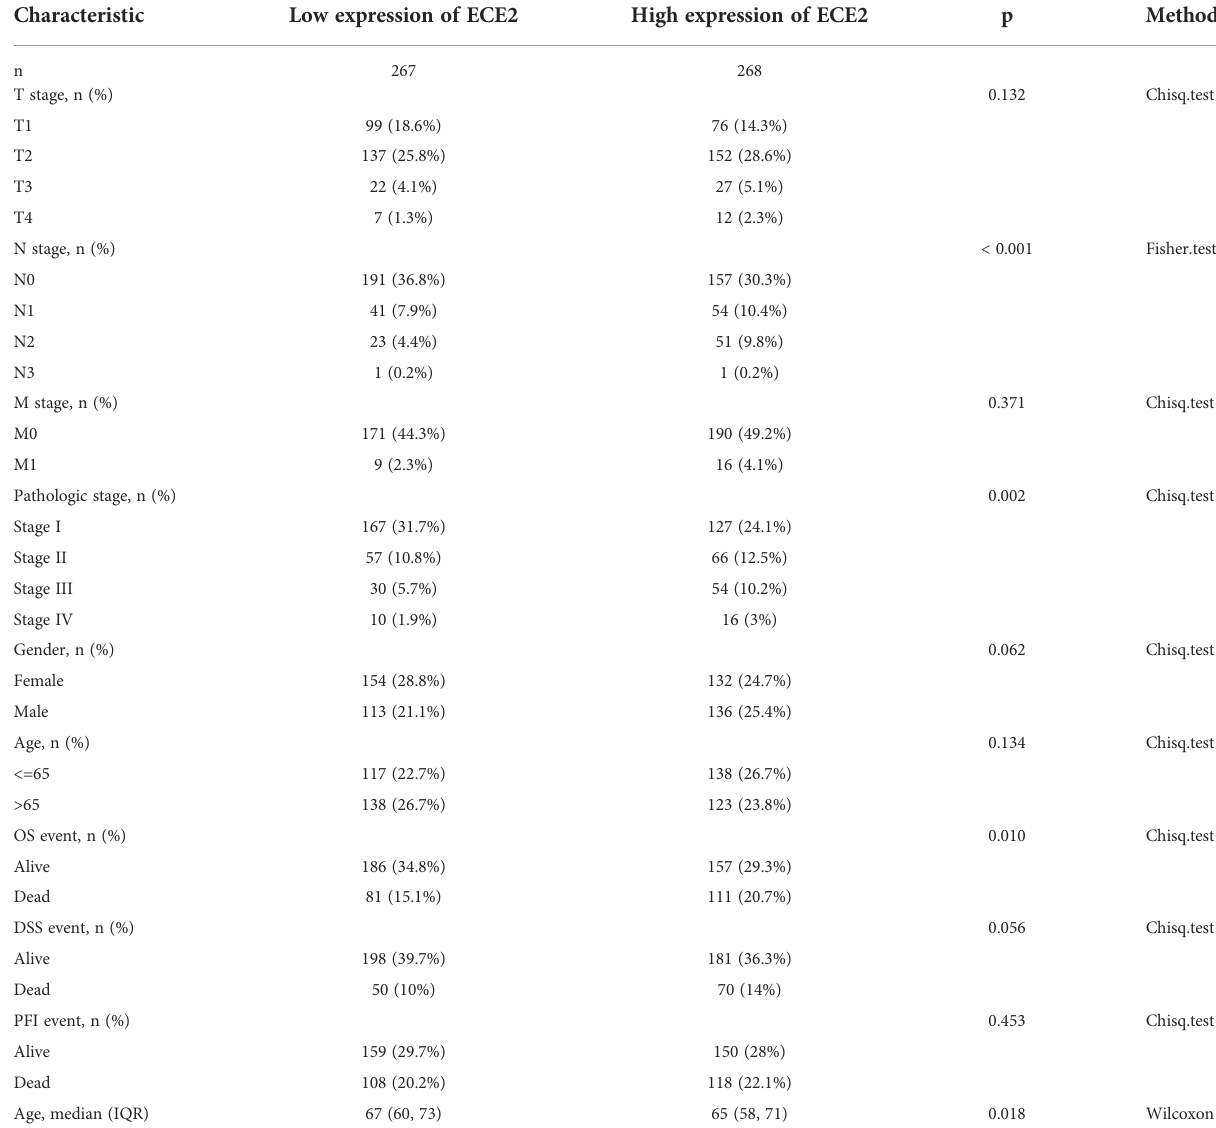
TABLE 1 Clinical characteristics of ECE2 in lung